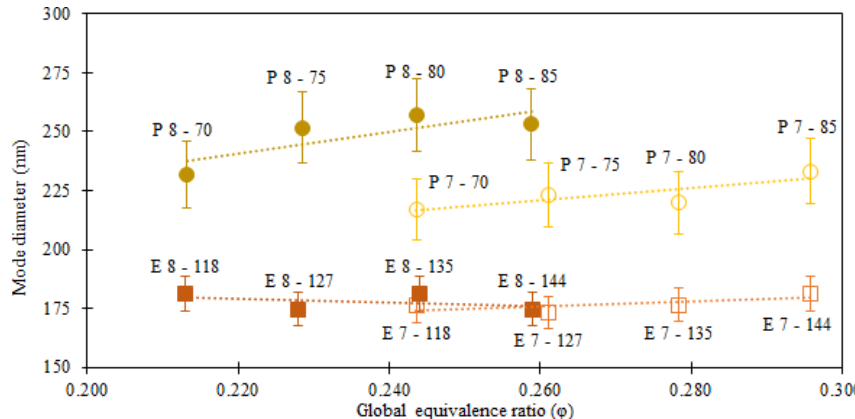
Figure 5. Mode diameter vs. the global equivalence ratio. Each point is indicated by E or P (ethylene or propane) and a pair of numbers indicating air and fuel flow rate, respectively (Lmin − 1 ; mLmin − 1 ). Dotted lines aim to guide the reader’s eye.